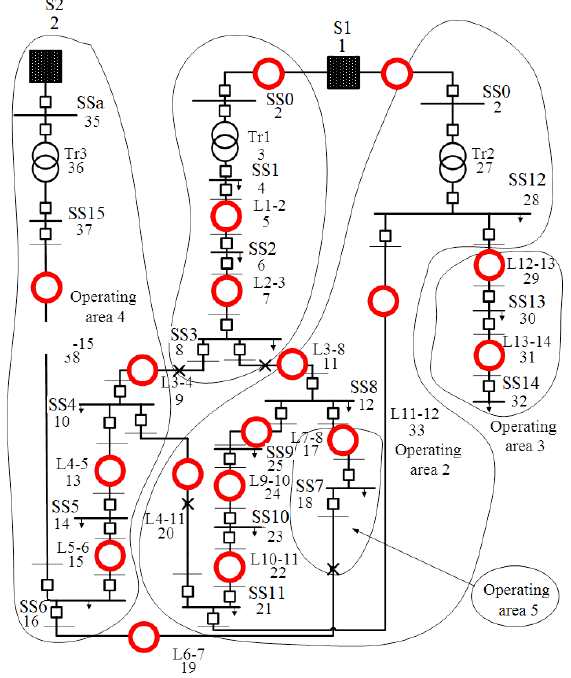
Figure 13. Power distribution network with points of installation of current and voltage sensors.